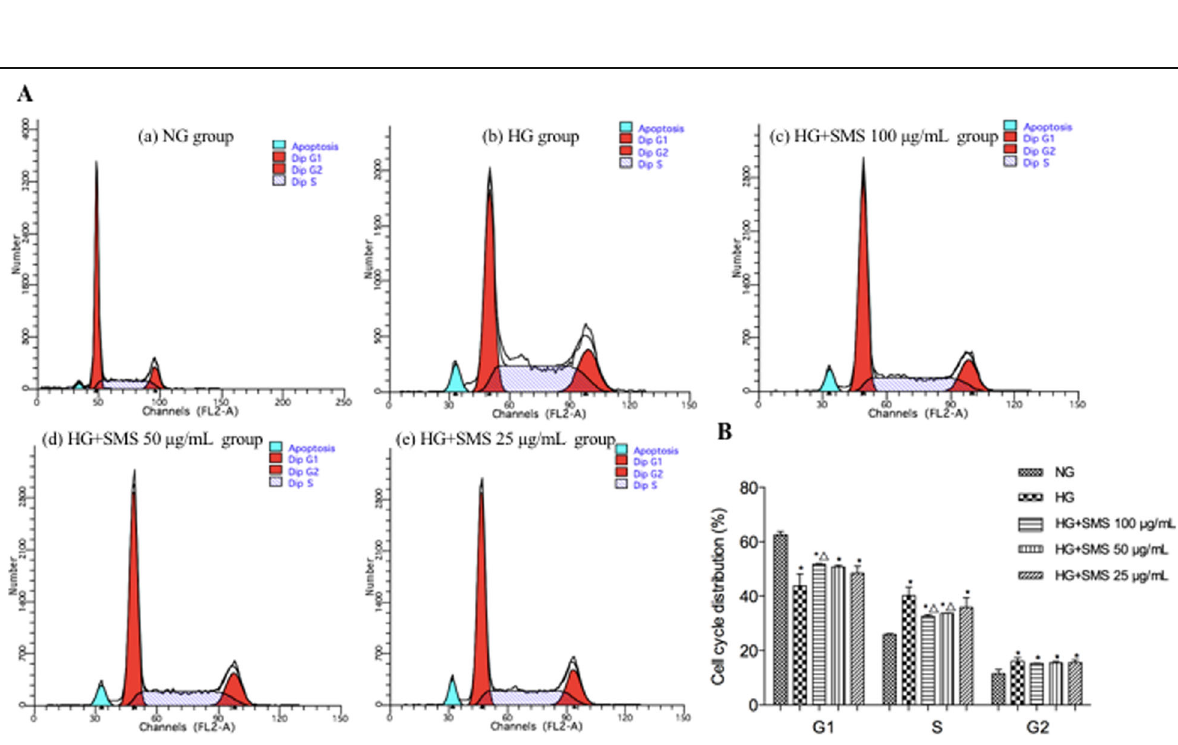
Fig. 4 Effect of SMS on the cell cycle in H9C2 cells. a The cell cycle of each group in H9C2 cells. b Distribution of cell cycle for H9C2 cells after treated with various concentrations of SMS for 24 h. (* p < 0.05: vs. NG group; △ p < 0.05: vs. HG